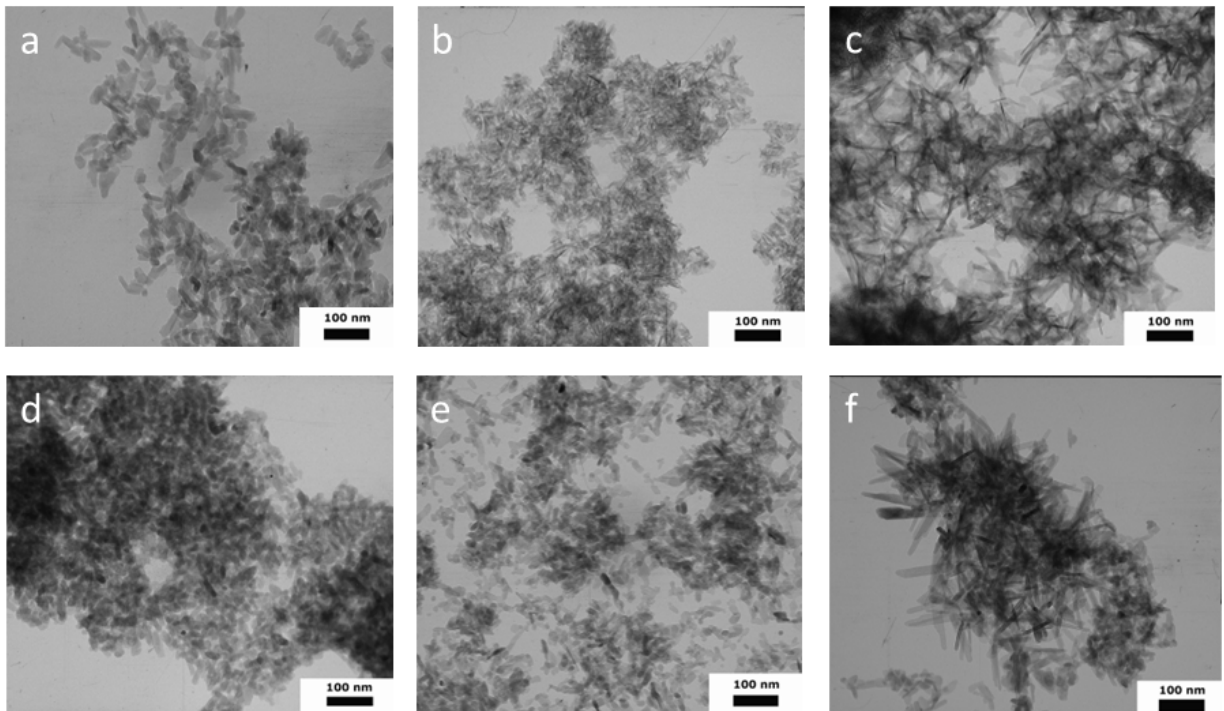
Figure 4. TEM images of HA powders synthesized in different media: W-1 ( a ), WA-1 ( b ), WE-1 ( c ), W-21 ( d ), WA-21 ( e ), WE-21 ( f ).